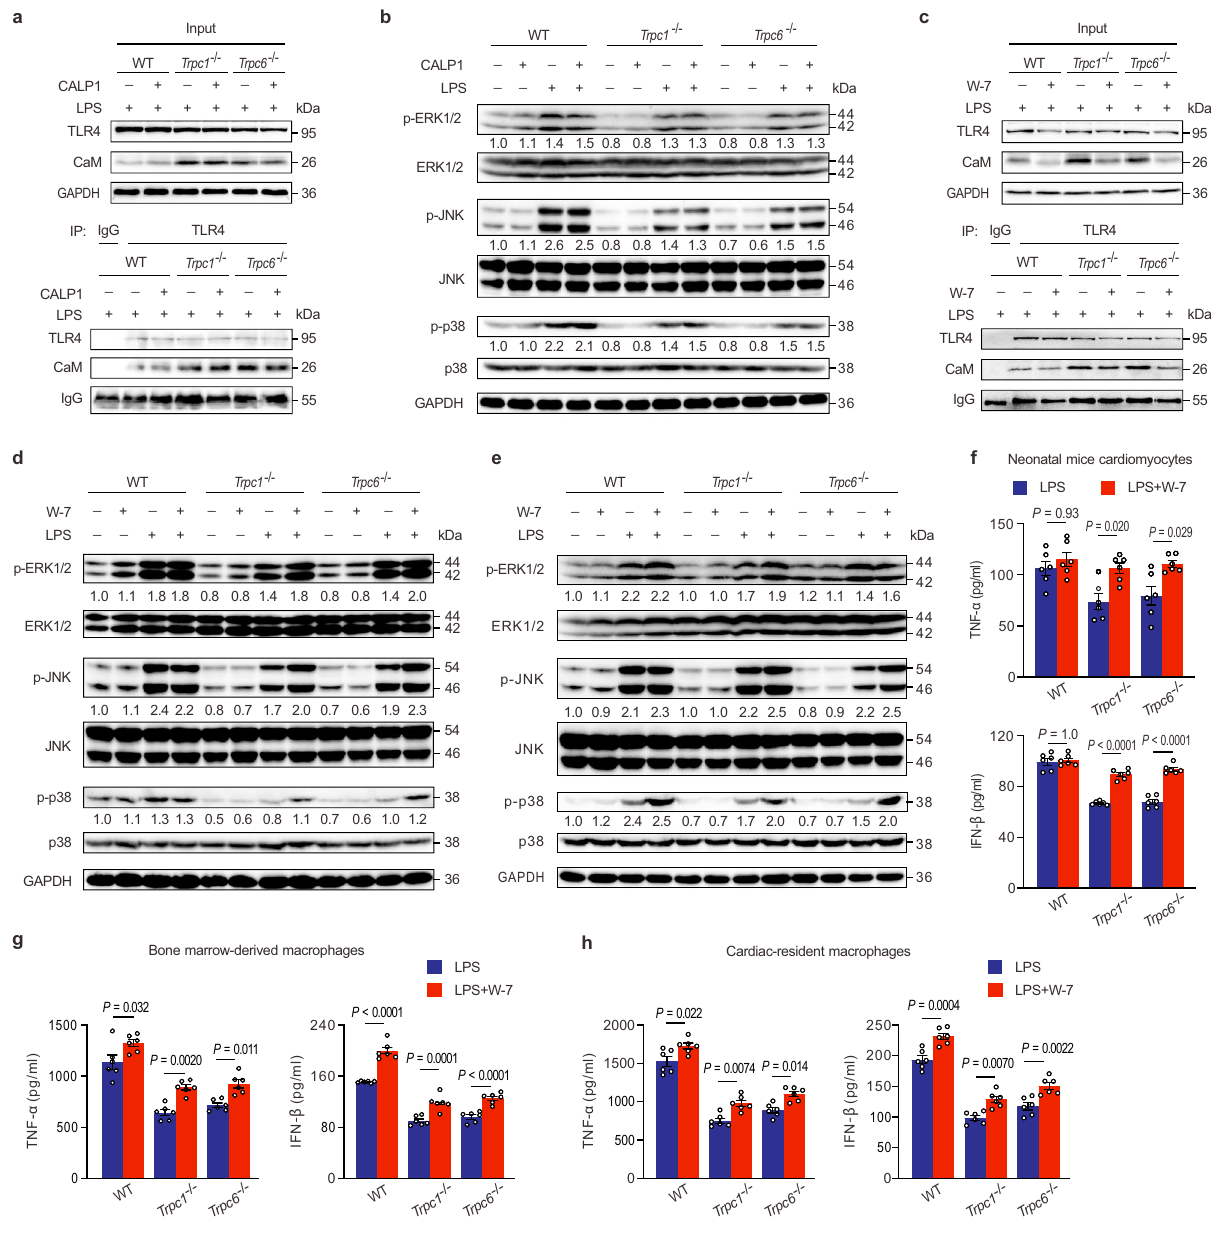
Fig. 5 | CaM interacts with TLR4 to inhibit the in fl ammation cascades. a The effectsofCALP1(20 μ M)pretreatmentontheinteractionbetweenCaMandTLR4in the LPS-stimulated neonatal mice cardiomyocytes ( n =2 biological independent experiments). b The effects of CALP1 on phosphorylated ERK, JNK, and P38 MAPK expressions in the LPS-stimulated neonatal mice cardiomyocytes ( n =3 biological independent experiments). c-d The effects of CaM inhibitor W-7 (30 μ M) pre- treatment on the interaction of CaM and TLR4, and MAPK activation in neonatal mice cardiomyocytes stimulated with LPS for 4h ( n =2 biological independent experiments for c and n =3 biological independent experiments for d ). e The